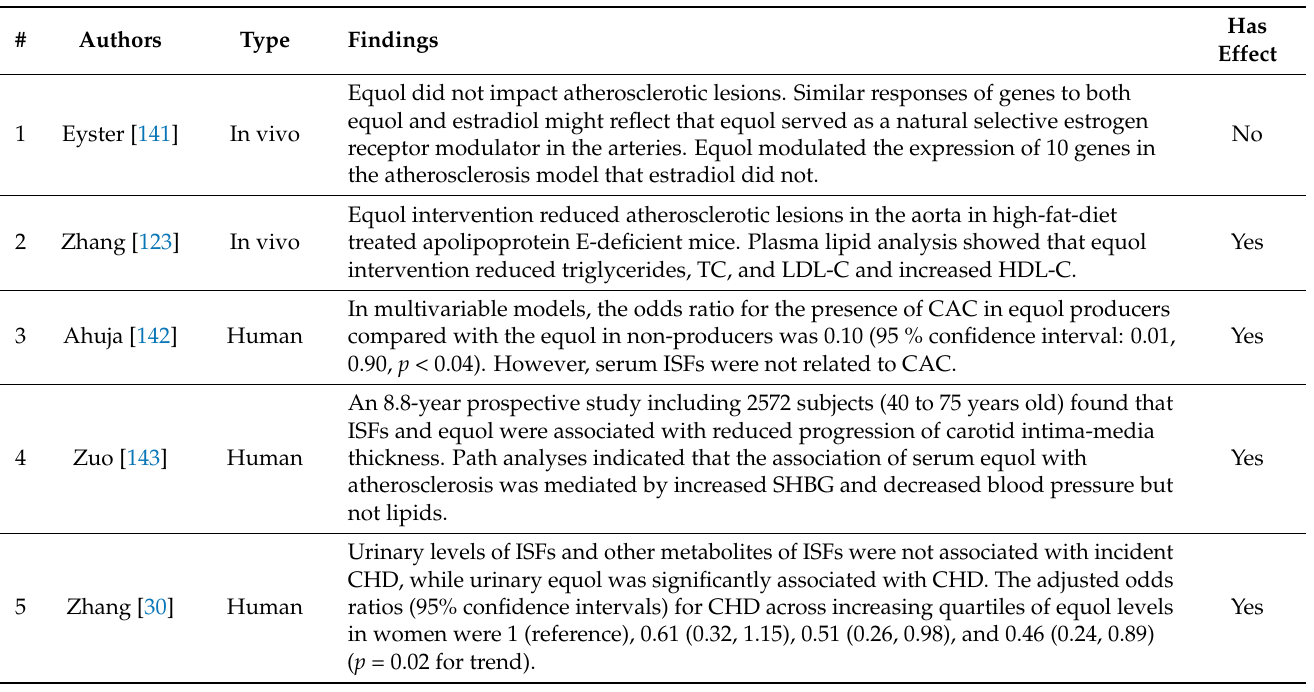
Table 5. Anti-atherosclerotic and CHD preventive effects of